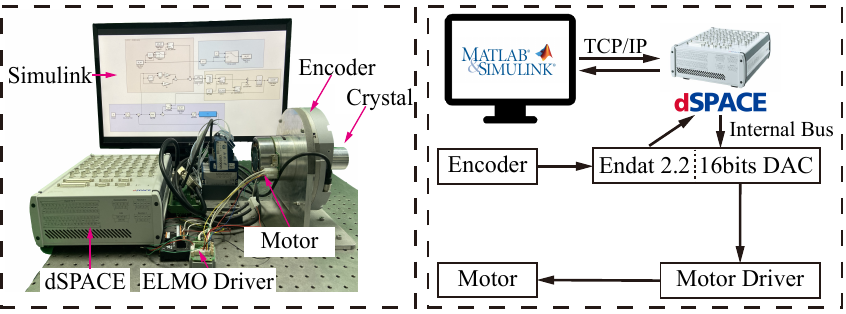
Figure 4. The experimental setup of the single axis motion